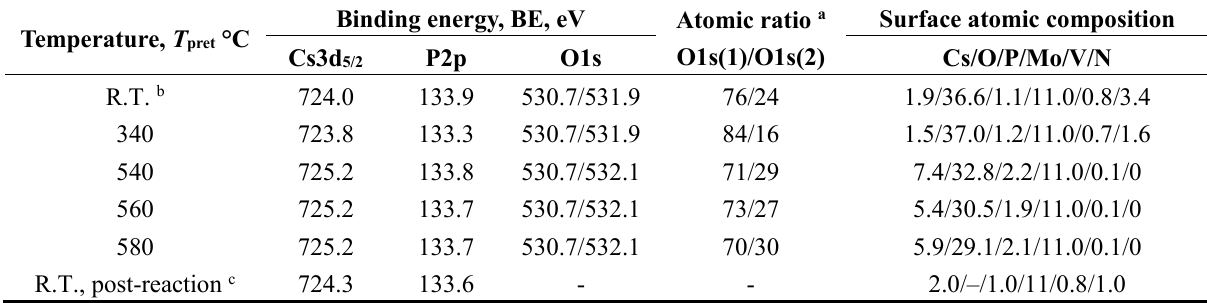
Table 3. Binding energy and surface atomic composition of 40 APMV/CPM pretreated under isobutane at various temperatures.